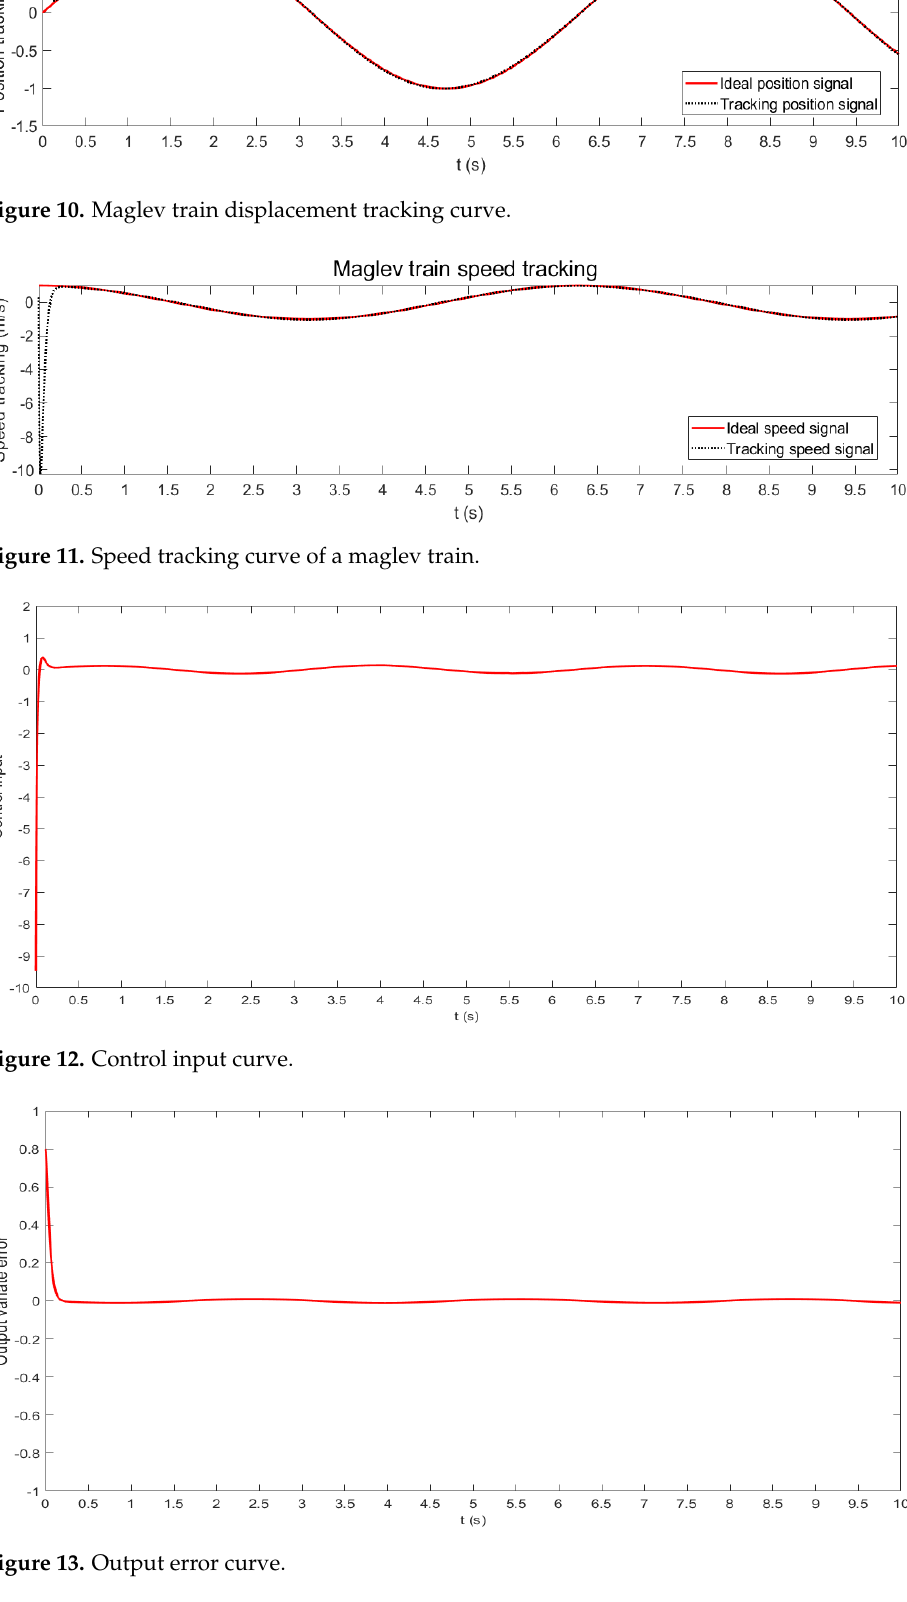
Figure 14. Maglev train displacement tracking curve. Figure 15. Speed tracking curve of a maglev train. Figure 16. Control input curve.